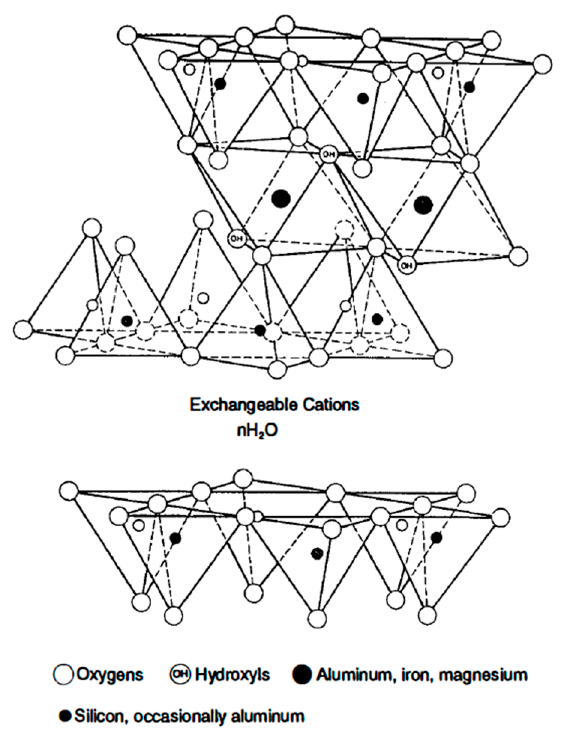
Figure 1. Crystal structure of montmorillonite [28].